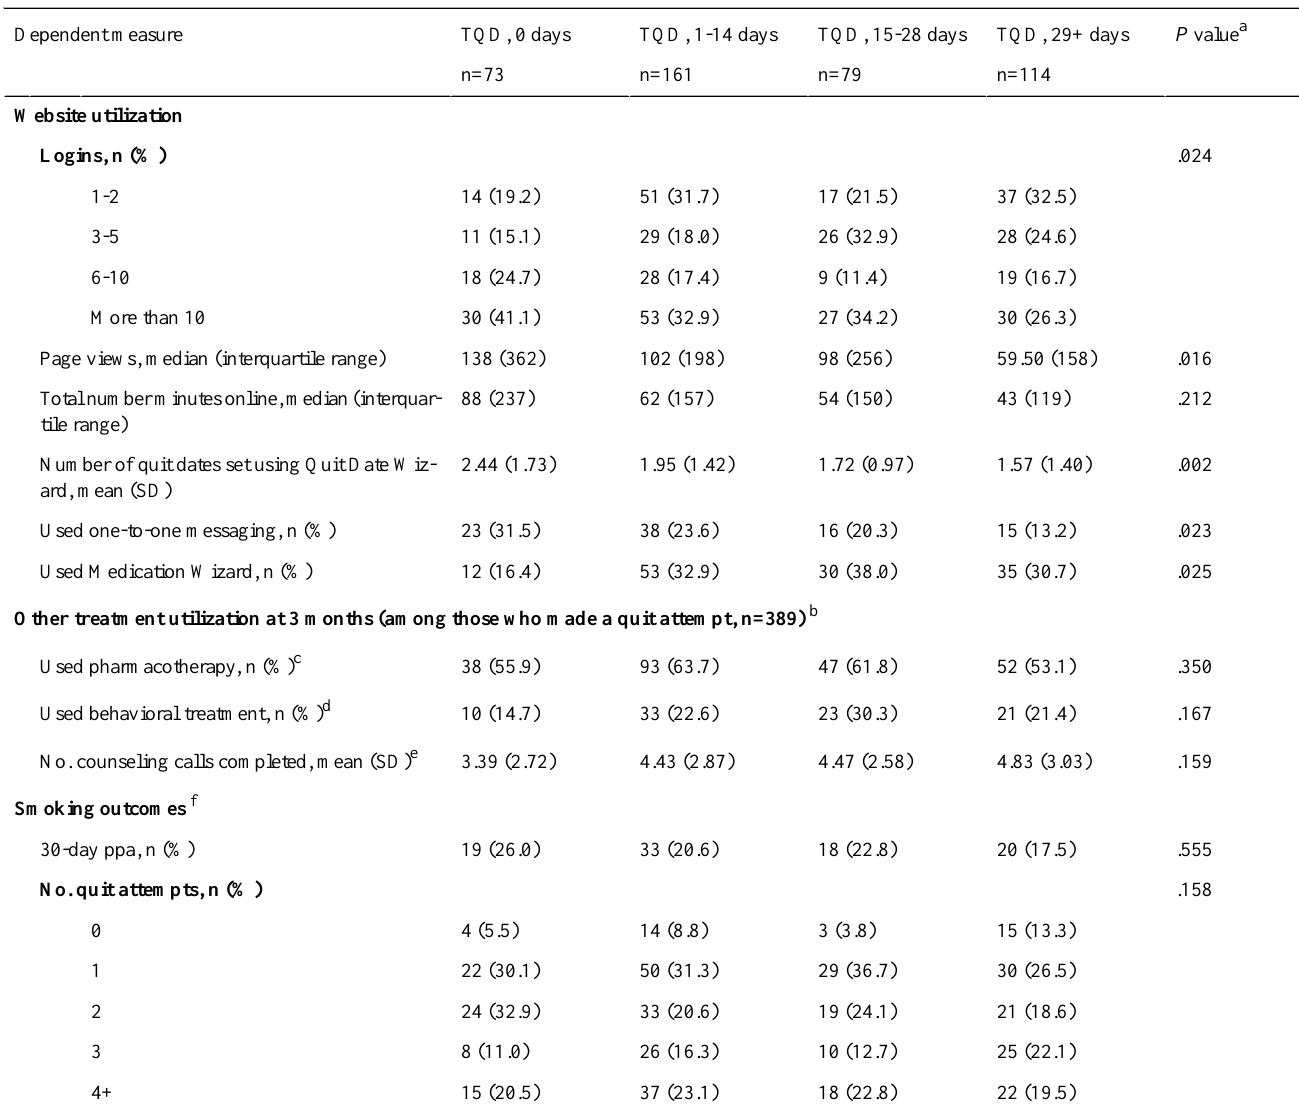
Table 2. Treatment utilization and smoking outcomes at 3 months by latency to target quit date (TQD) relative to website registration date.